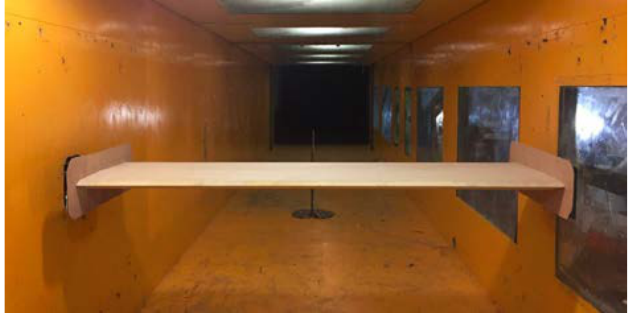
Figure 9. Aerodynamic derivative identification test.